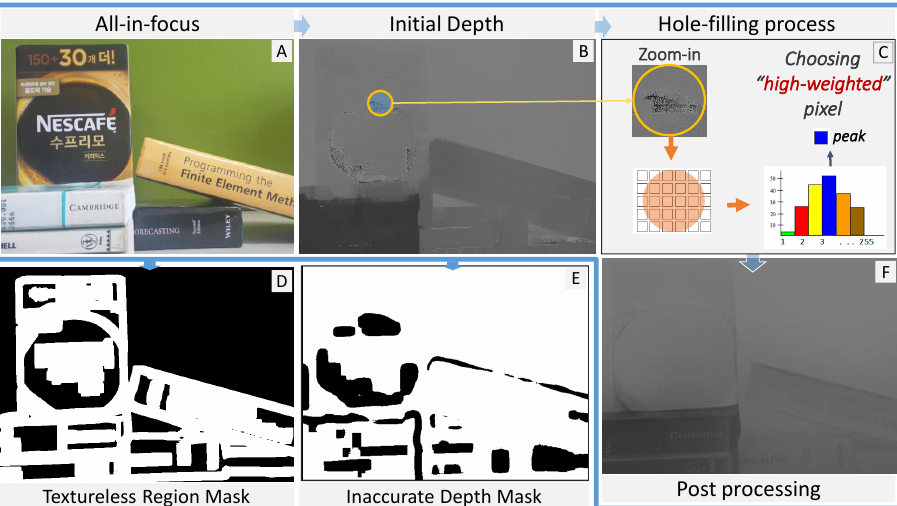
Figure 9. A hole-filling process on textureless regions that produce erroneous depth values (note: coffee box and the wall (background) are close to each other, so they have almost similar depth). ( A , B ) images are all-focused-image and initial depth map; ( C ): Hole-filling process; ( D ): Textureless Region Mask; ( E ): Inaccurate Depth Mask; ( F ): Post